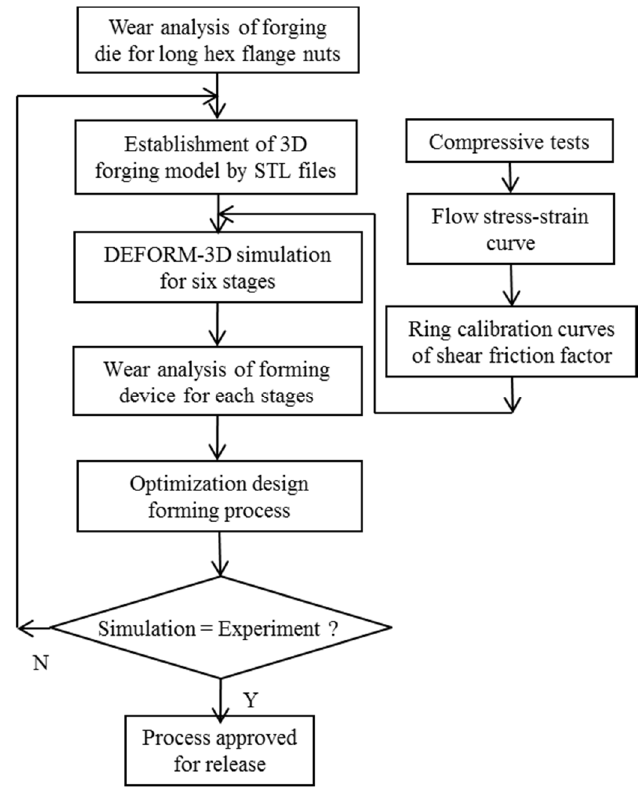
Figure 1. Flowchart of the study.